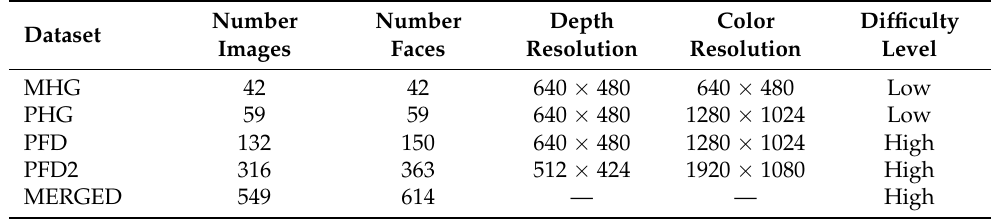
Table 1. Main characteristics of the